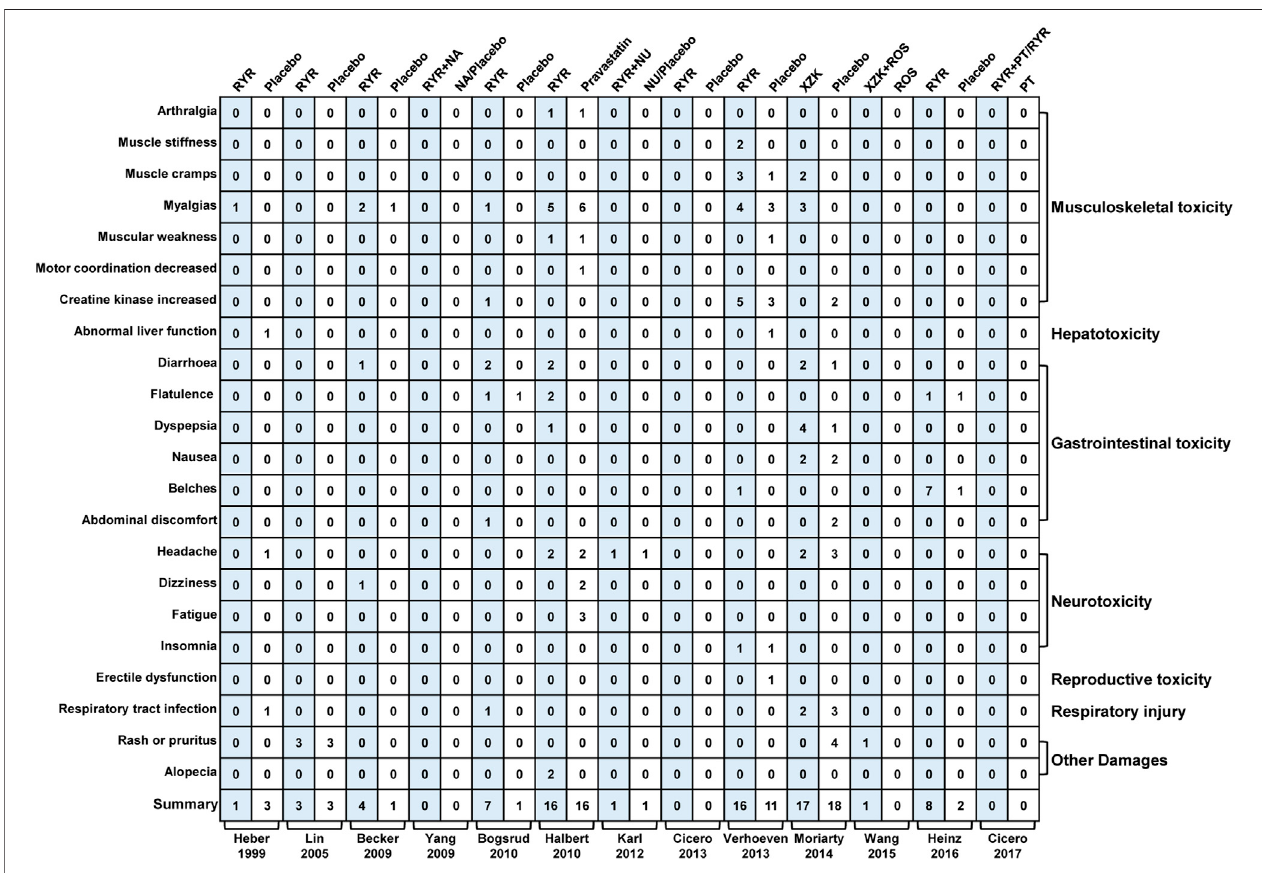
FIGURE 5 | Mapping of adverse events between RYR and placebo groups. (RYR: red yeast rice; NA: nattokinase; NU: nutraceutical; XZK: xue-zhi-kang capsule; PT: phytosterols; ROS: rosuvastatin).